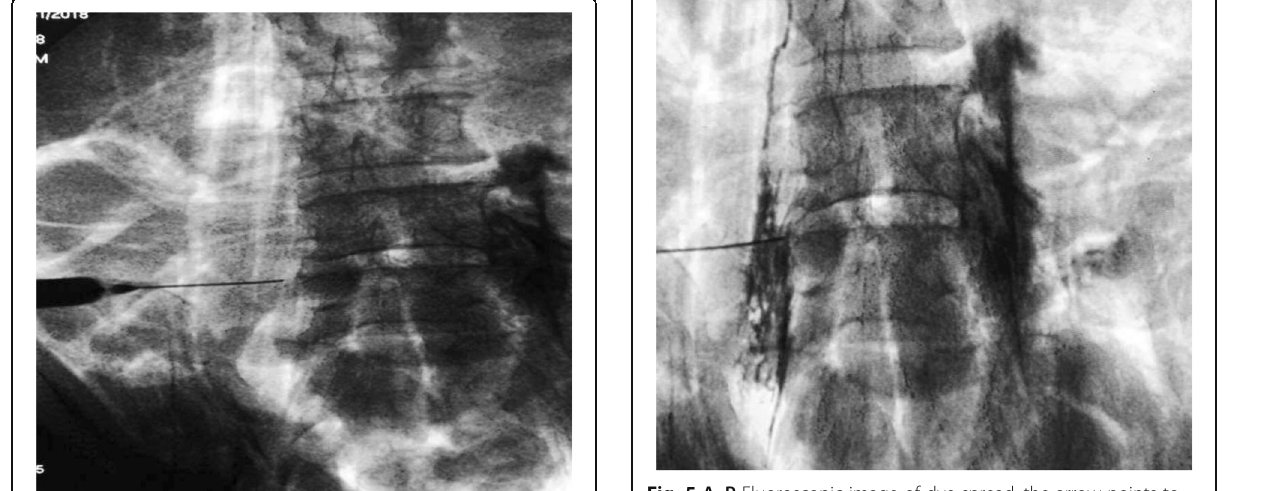
Fig. 5 A – P Fluoroscopic image of dye spread, the arrow points to the dural sleeve spread of dye, and the circle is overlying